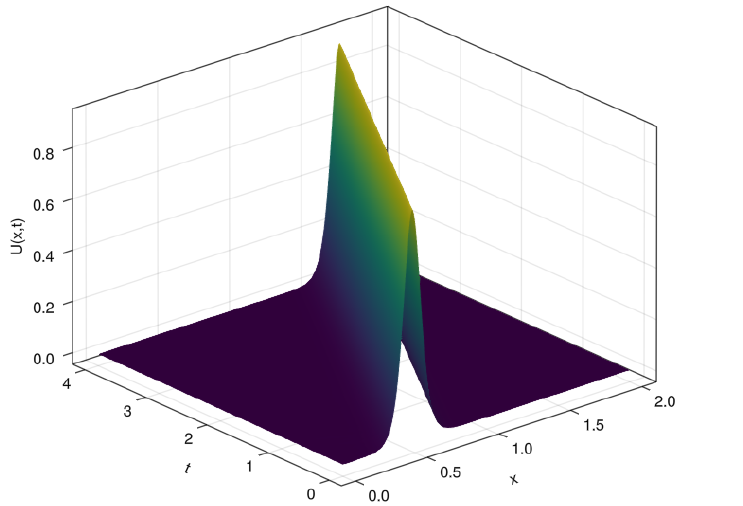
Figure 8. 3D surface plot for the approximate solution for Example 4.